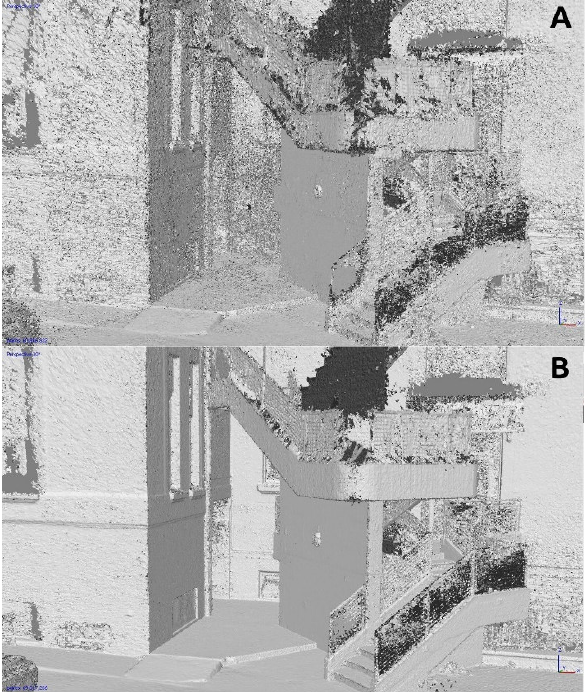
Figure 11. Visual inspection of the Dense Cloud generated in Photoscan. 360 configuration: automatic process with native Exif (A), process with modified Exif (B).